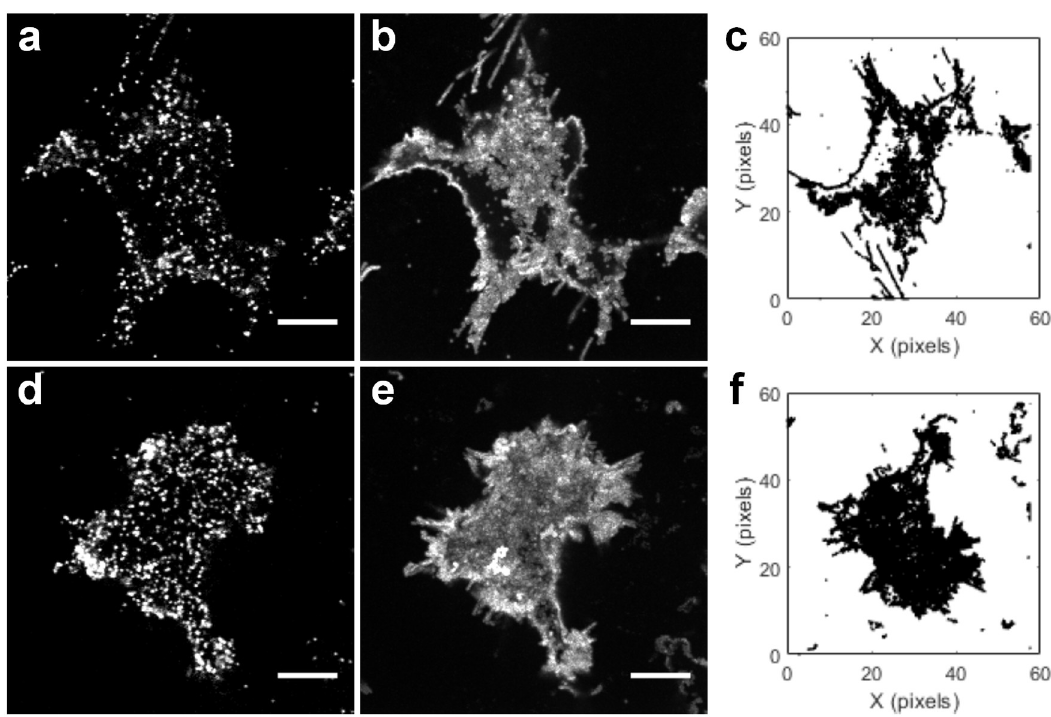
Fig 4. Uniformity of D2DR-Qdot lateral diffusion at the cell-coverslip interface independently of the labeling approach. (a) A single frame showing HA-tagged D2DR labeled with anti-HA-biotin and Qdot605Sav. Scale bar: 10 μ m. (b) A maximum intensity projection showing D2DR-Qdot motion over 60 s acquired at 10 Hz. Scale bar: 10 μ m. (c) Reconstructed trajectories depicting D2DR-Qdot motion in b. Scale: 1 pixel = 0.22 μ m. (d-f) D2DR-HA labeling and tracking with biotinylated IDT772 and Qdot605Sav in HEK-293T cells. Images are representative of three independent experiments. Two MatTek dishes plated per passage with two to three 512x512 fields of view acquired per MatTek dish constituted an independent experiment.